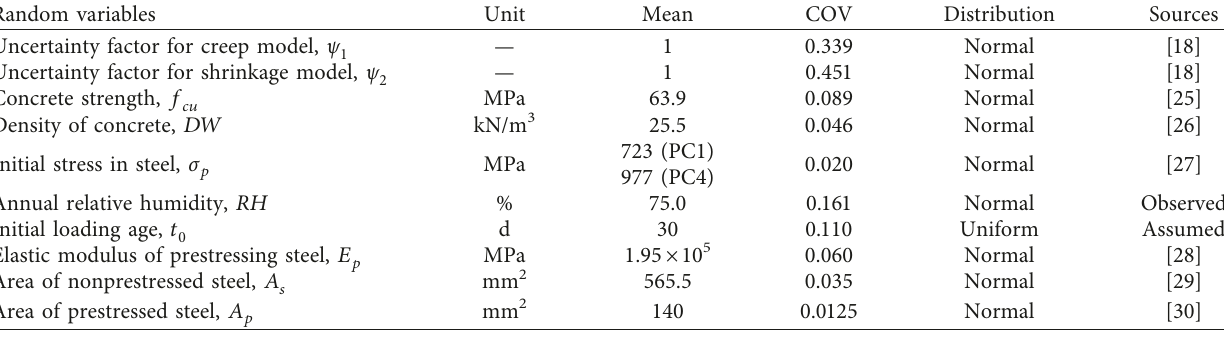
Table 4: Statistical properties of random variables.